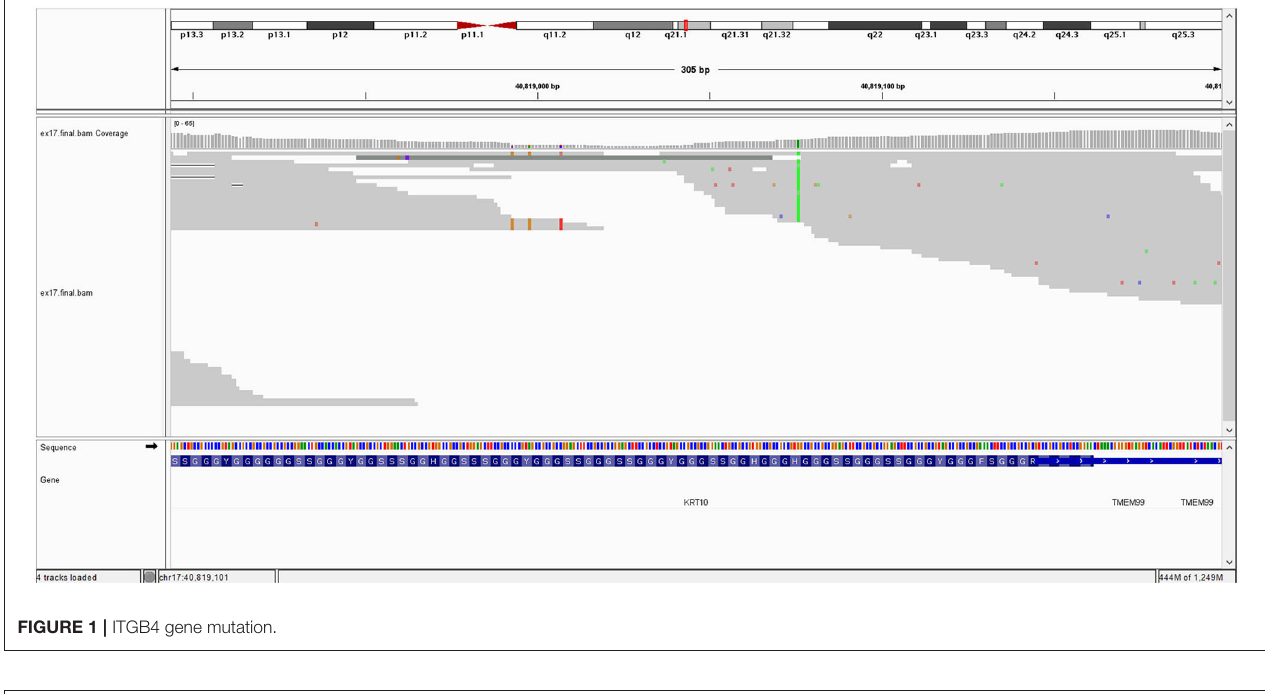
FIGURE 1 | ITGB4 gene mutation.